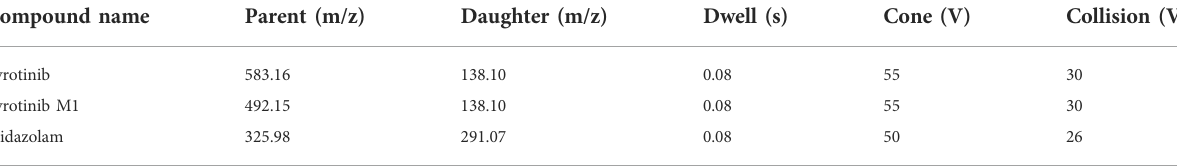
TABLE 1 The transition parameters of pyrotinib, pyrotinib M1, and midazolam.